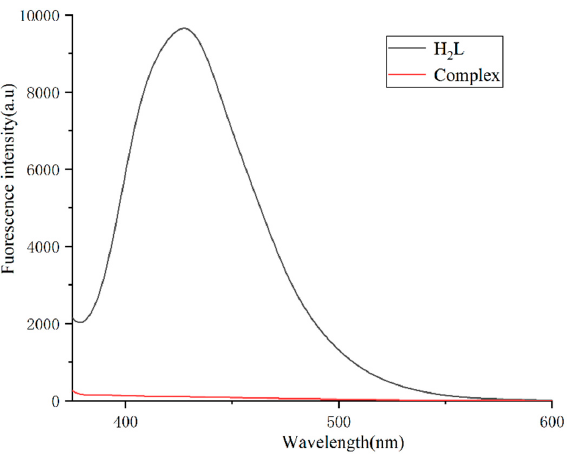
Figure 6. Fluorescent spectra of H 2 L and its Cu II complex (  ex = 349 nm).